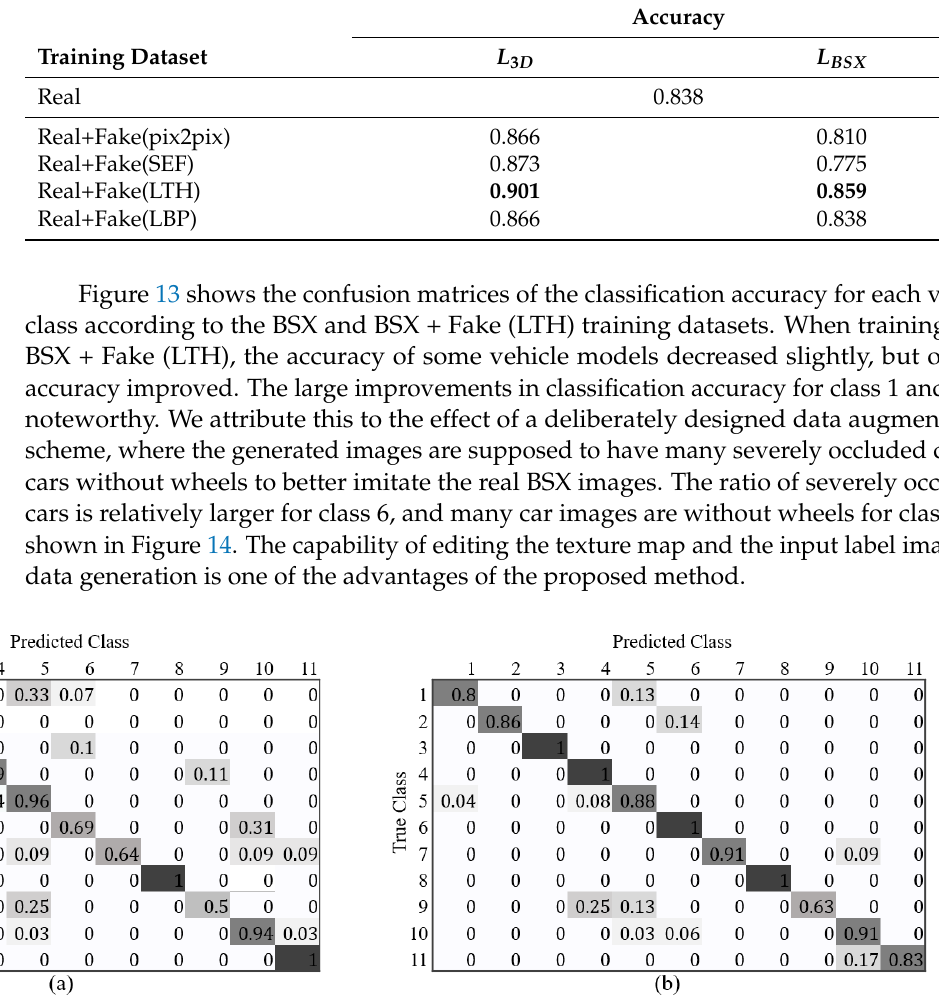
Figure 13. Confusion matrix of classification accuracy according to training set: ( a ) BSX only; ( b ) BSX + Fake (LTH) with L 3 D